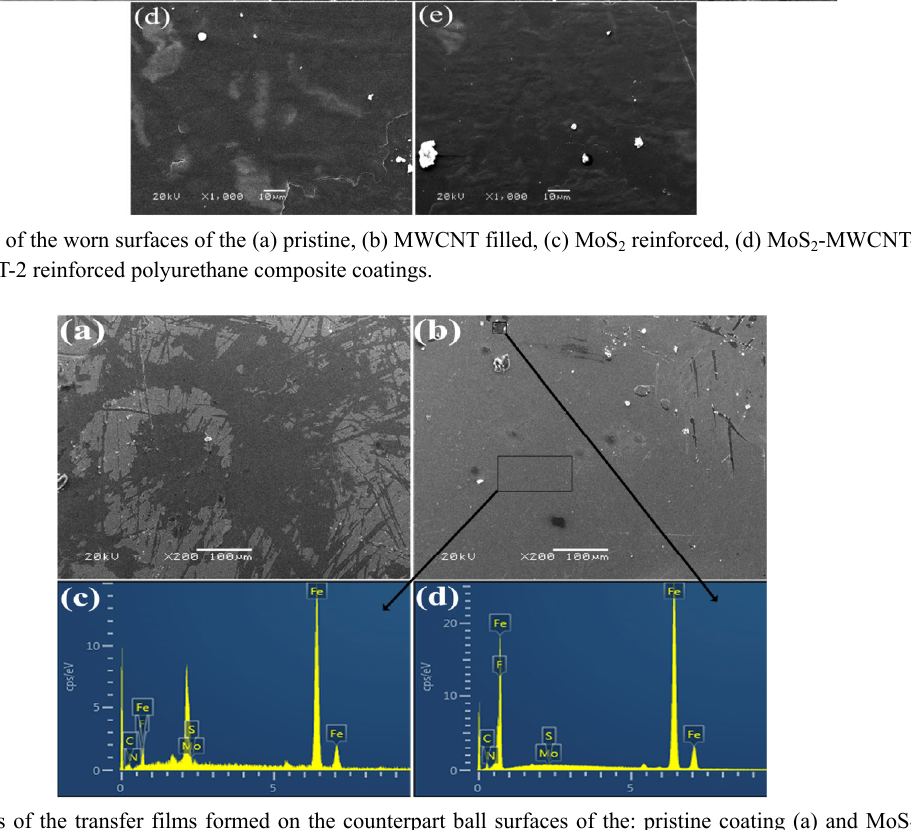
Fig. 11 EDS analysis of the transfer films formed on the counterpart ball surfaces of the: pristine coating (a) and MoS 2 -MWCNT-1 reinforced polyurethane composite coatings (b) −